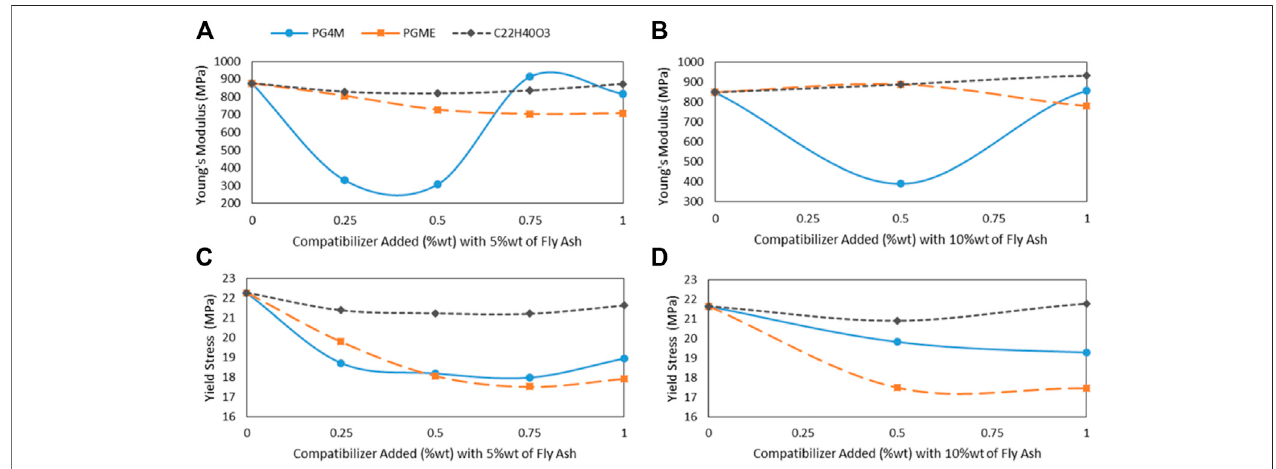
Frontiers in Materials |